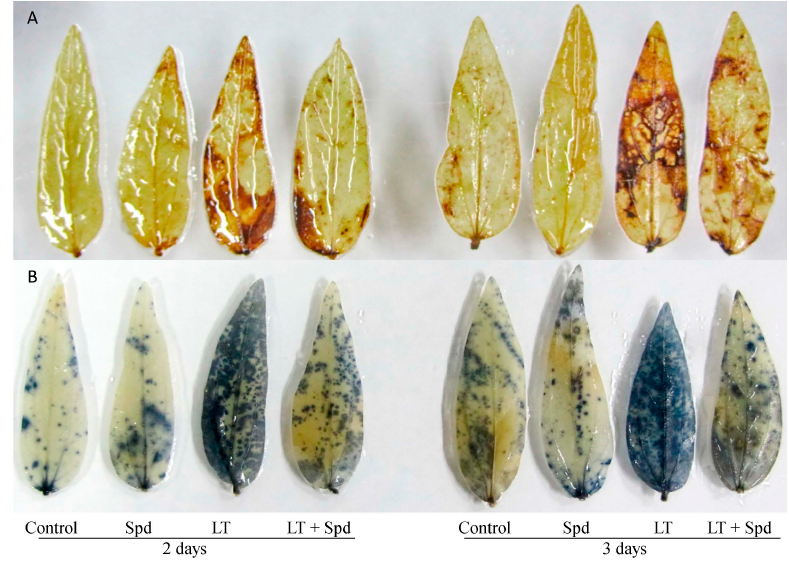
Figure 2. Histochemical localization of H 2 O 2 ( A ); and O 2• − ( B ) in mung bean leaves. Spd and LT indicate spermidine (0.25 mM) and low temperature (6 °C), respectively.